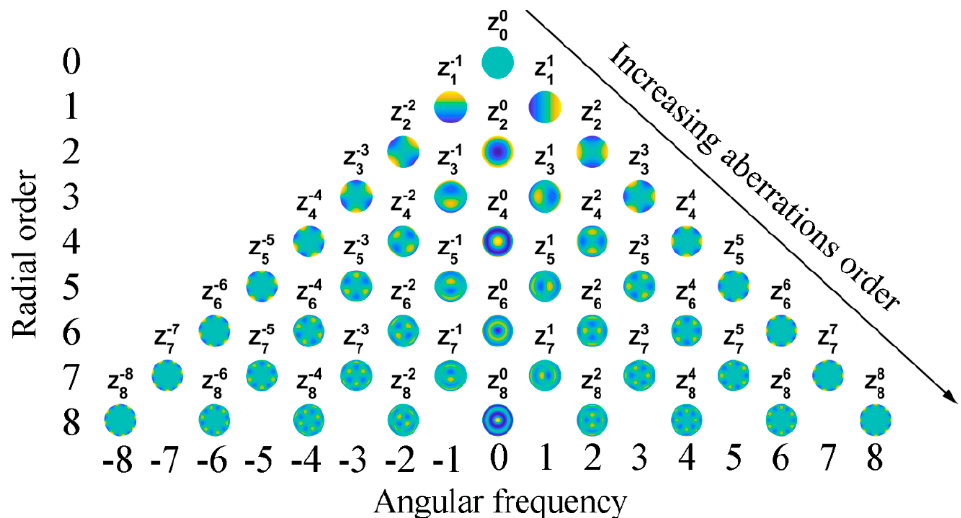
Figure 2. Zernike pyramid. As for previous figure colors towards yellow indicate positive deviations, while those towards blue indicate negative deviations. Zero deviations are indicated in teal color